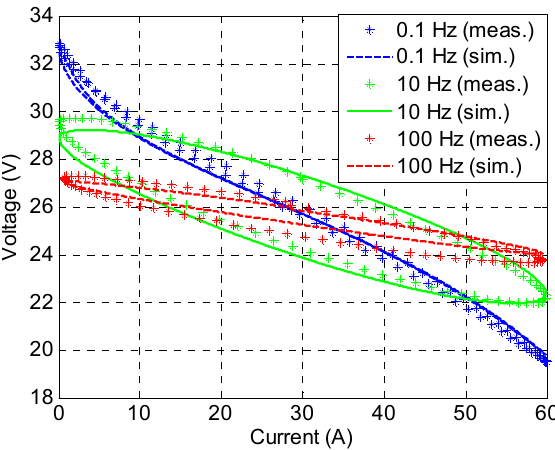
Figure 13. Dynamic experimental validation test of the FC models: current - voltage of the simulated results (sim) and measured results (meas) for the FC for an operating temperature of 52 °C when required to supply a sine wave current with a peak-to-peak amplitude of 60 A and frequencies of 0.1, 10 and 100 Hz, superimposed on a DC current of 30